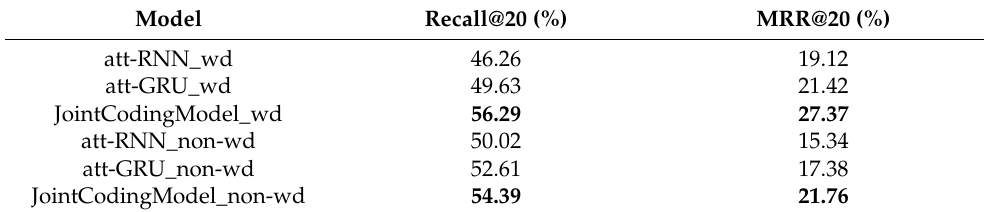
Table 7. Experimental results of the workday and non-workday